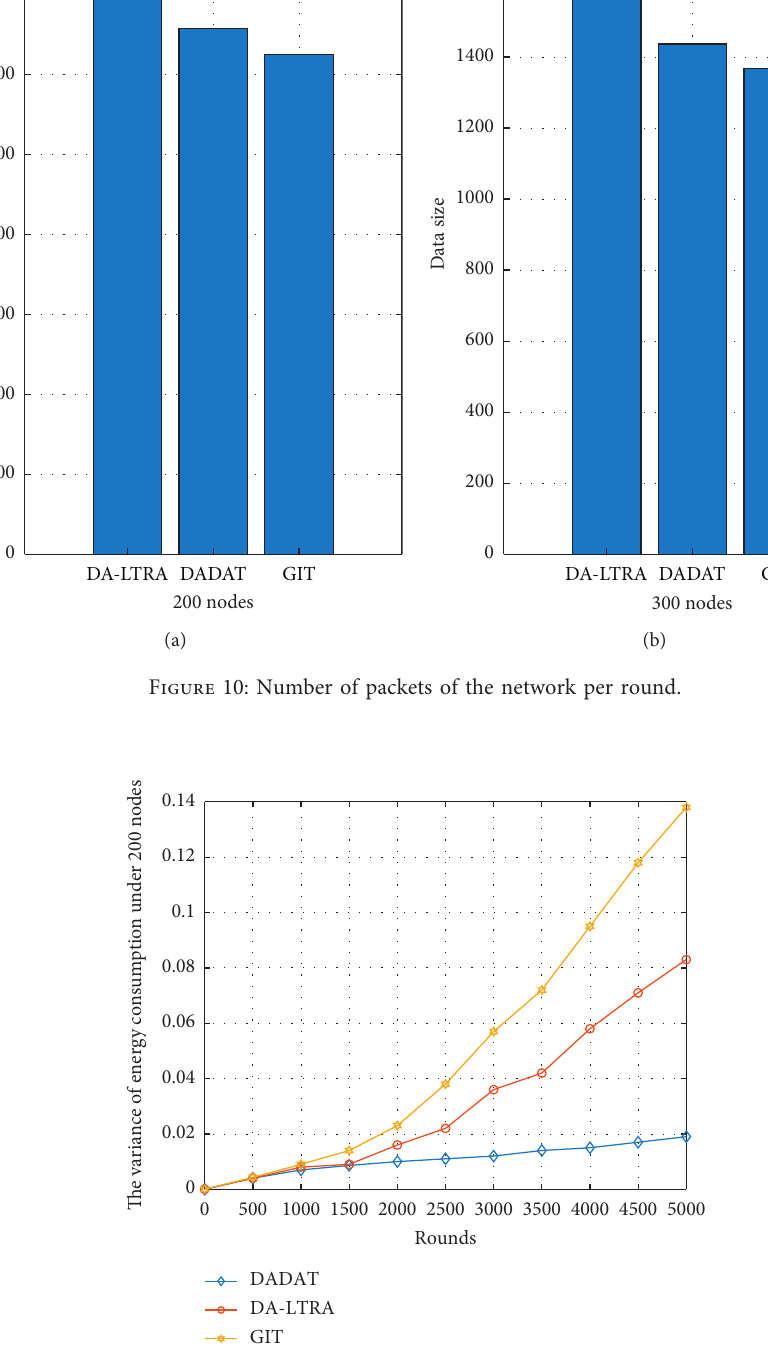
Figure 11: Variance of energy consumption under 200